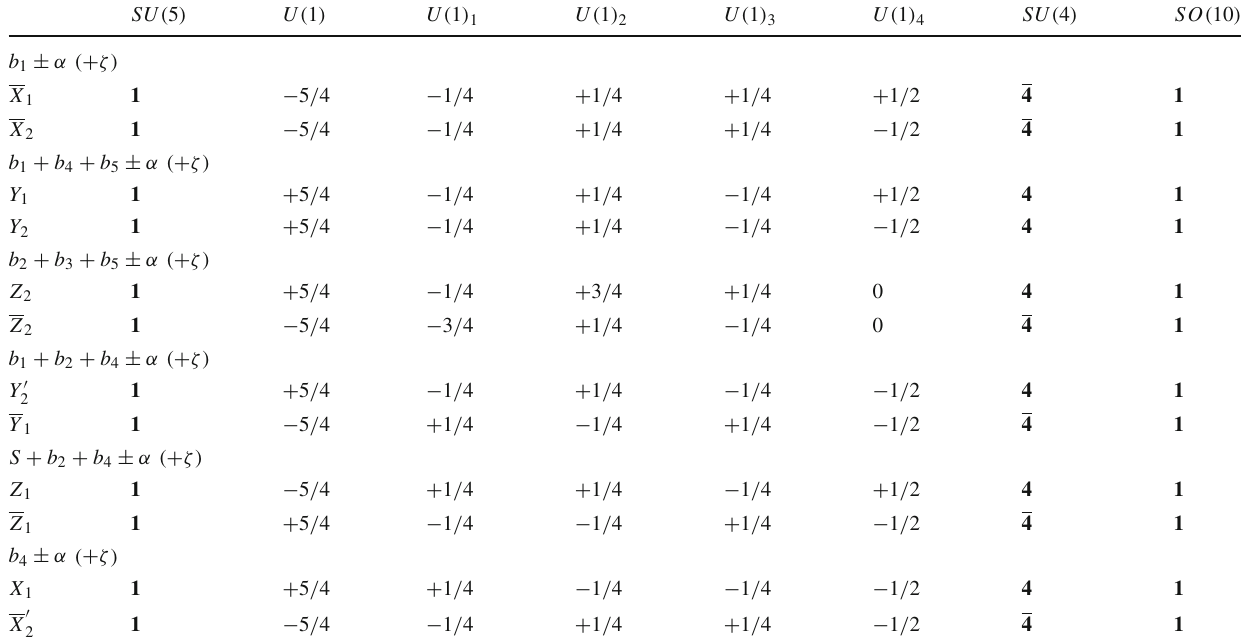
Table 4 Exotic fractionally charged massless matter states and their SU ( 5 ) × U ( 1 ) × U ( 1 ) 4 × SU ( 4 ) × SO ( 10 ) quantum